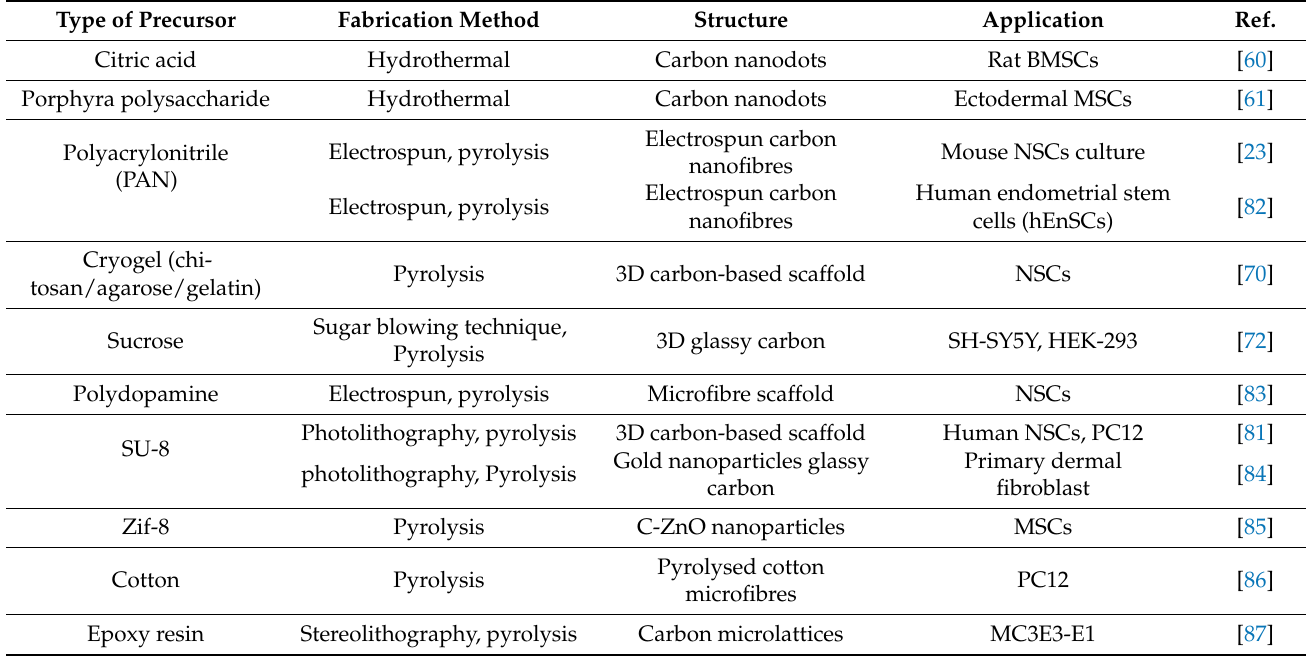
Table 2. Carbon precursor in biological